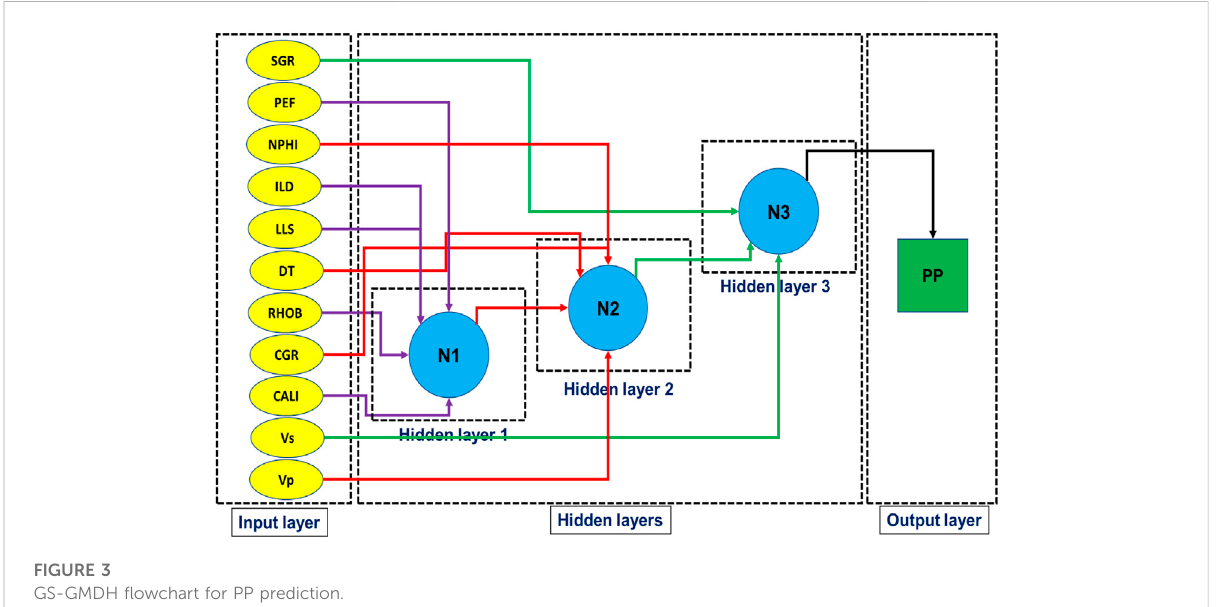
FIGURE 3 GS-GMDH fl owchart for PP